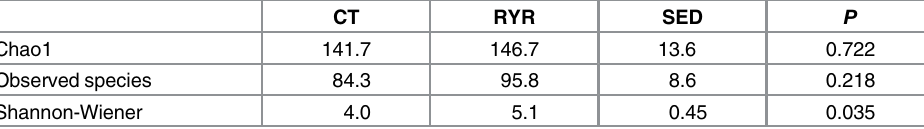
Table 7. The effect of replacement of ordinary rice with red yeast rice on alpha diversity of archaeal communities at a depth of 720 sequences in goats (n =